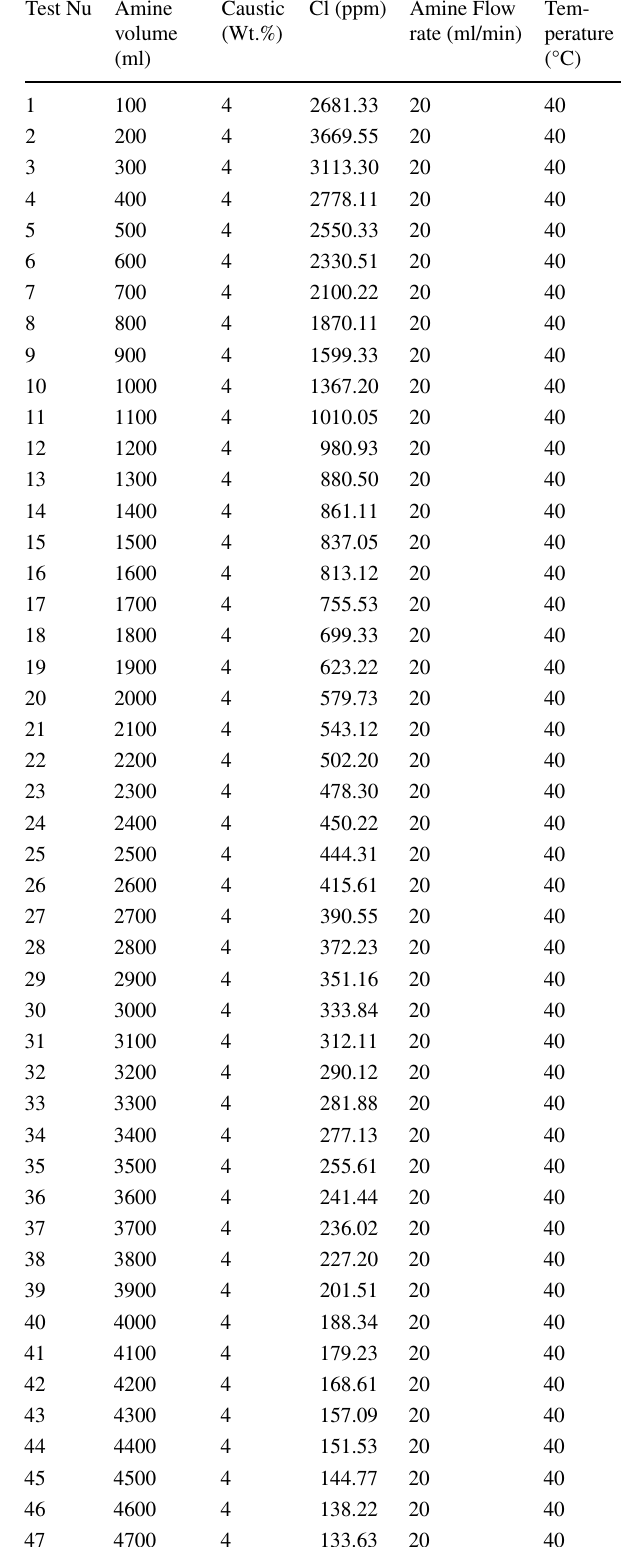
Table 4 Results of passing 4% caustic solution to recovery of the resin